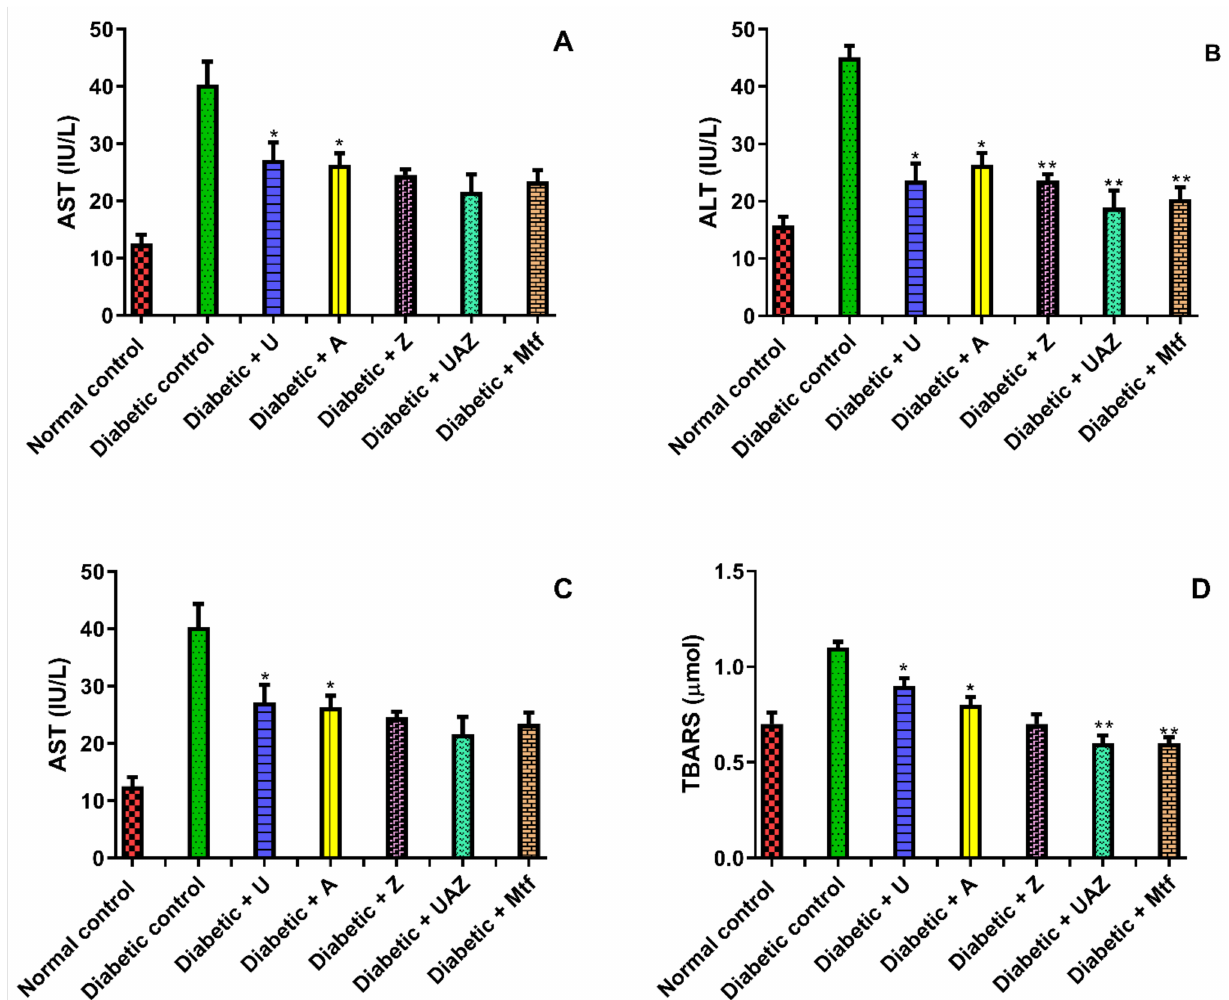
Figure 3. Effects of UZA, U, A, and Z treatment on marker in liver ( A ) ASTL; ( B ) ALT; ( C ) ALT; ( D ) TBARS levels; Data are presented as the means ± SD (n = 6). ** p < 0.001, * p <